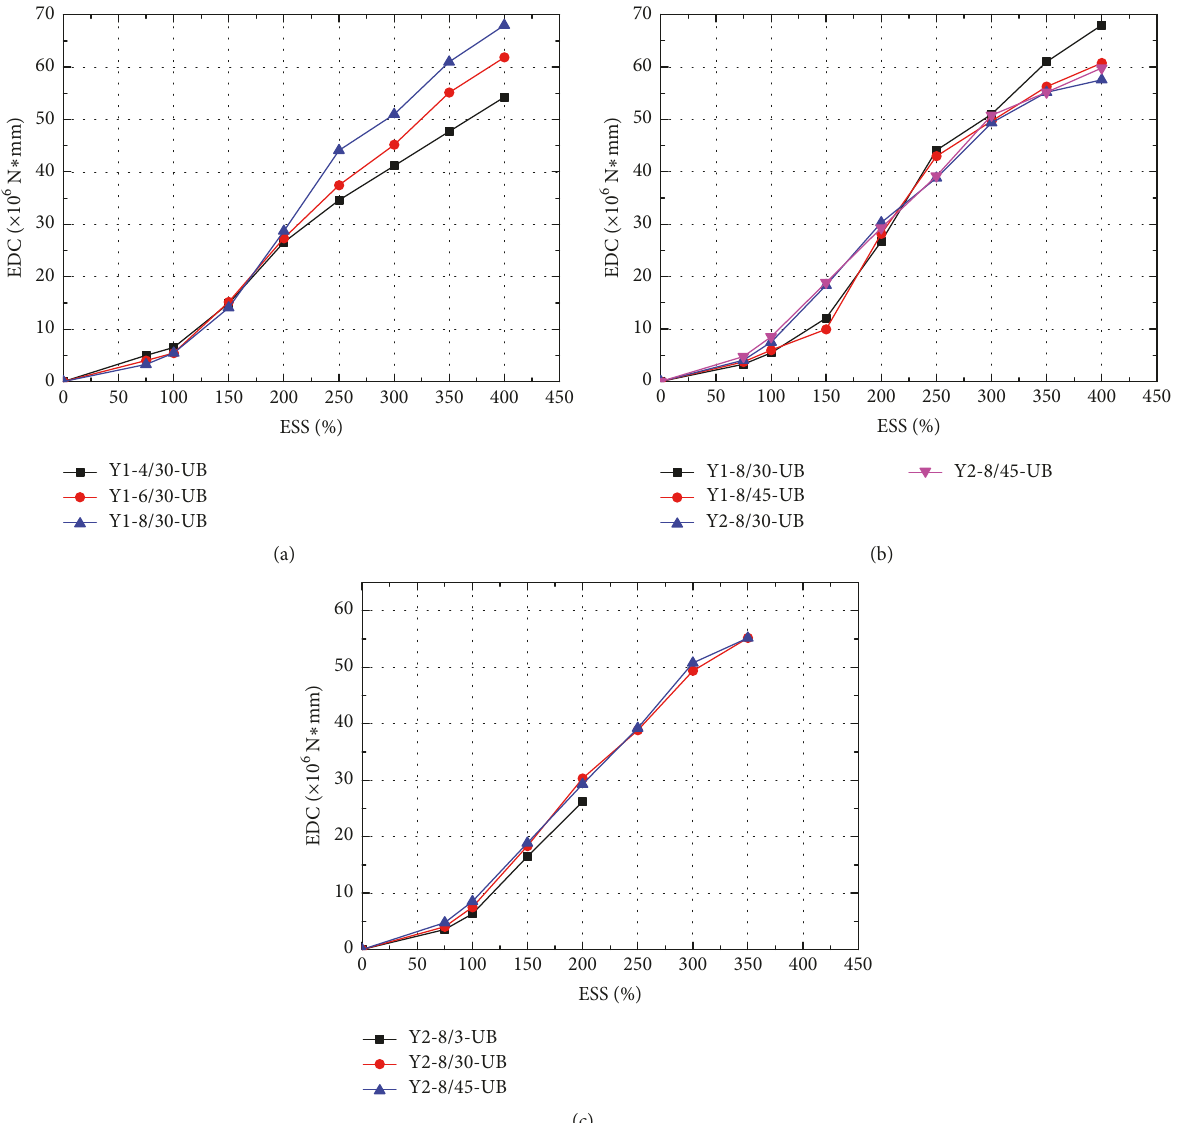
Figure 9: EDC for cyclic test: (a) different vertical stresses; (b) different rubber materials; (c) different loading rates.